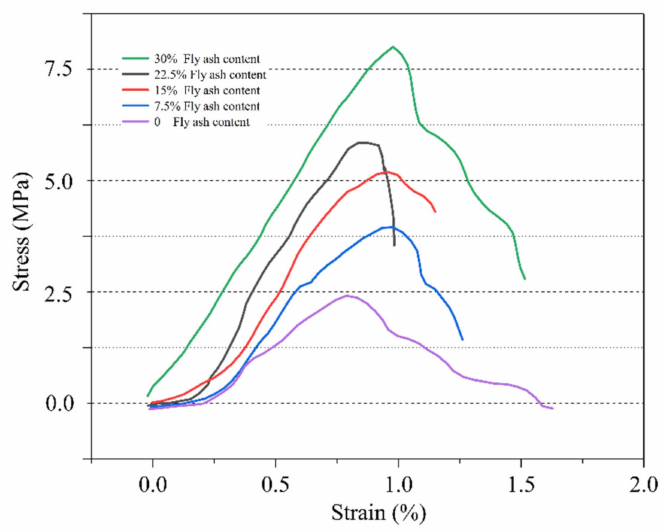
Figure 11. Stress–strain curves of Non-LB under 28 d.